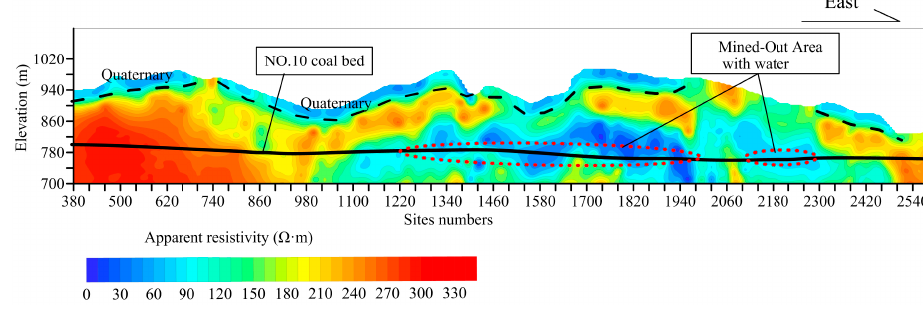
Figure 9. Inversion results of line 880.